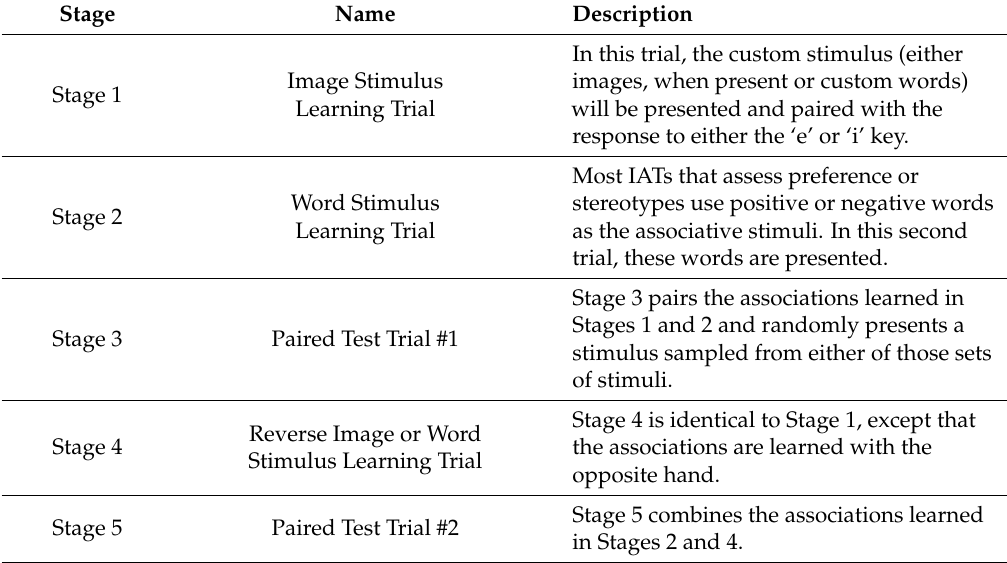
Table 1. Progression of IAT